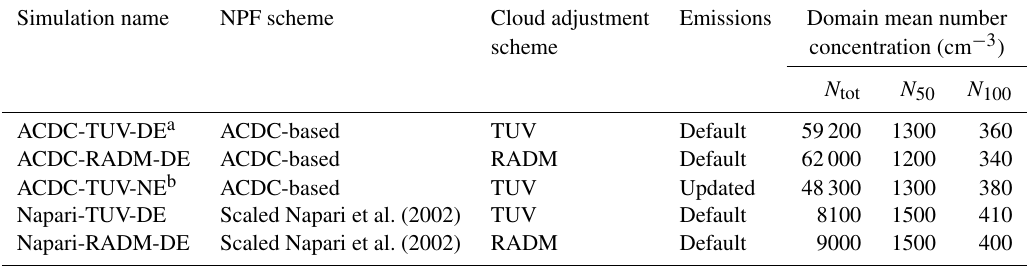
Table 1. Summary of PMCAMx-UF model simulations reported in this study. The arithmetic mean of ground-level number concentration during May 2008 for particles larger than 0.8nm ( N tot ), 50nm ( N 50 ) and 100nm ( N 100 ) is given for each